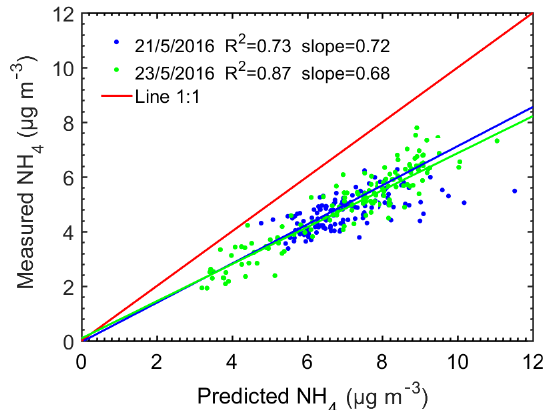
Figure 7. Mass concentrations of measured ammonium ( NH 4 ) ver- sus predicted ammonium assuming full neutralization of sulfate, ni- trate, and chloride on the whole day of 21 May 2016 (blue dots, Case I) and 23 May 2016 (green dots, Case II). The solid blue and green lines are the least-squares regression lines for each day. The 1 : 1 line is shown in red.